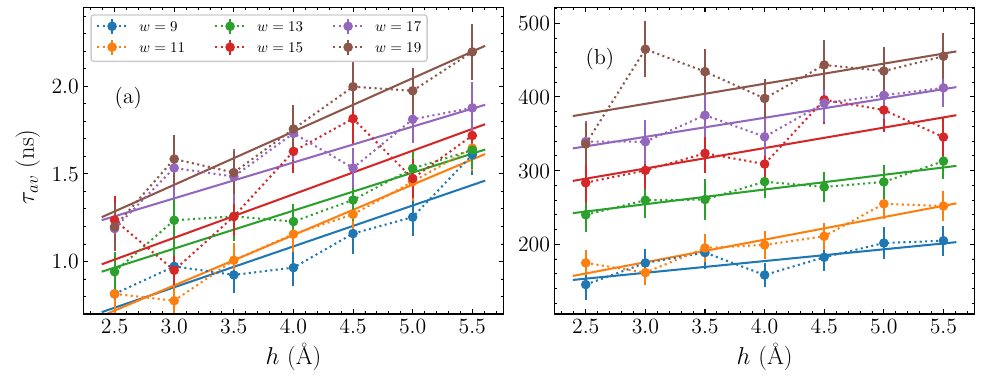
Figure 5. The average time τ av , Equation (11), of the stretched exponential fitted to the autocorrelation functions C E ( t ) (Equation (8)), obtained from the parameters shown in Figure 4, ( a ) for the AT sequences and ( b ) for the GC sequences (points). The dotted lines guide the eye for point-connection. The amplitude dependence of the average time is fitted by a linear function (see Equation (12)), depicted by solid lines in ( a , b